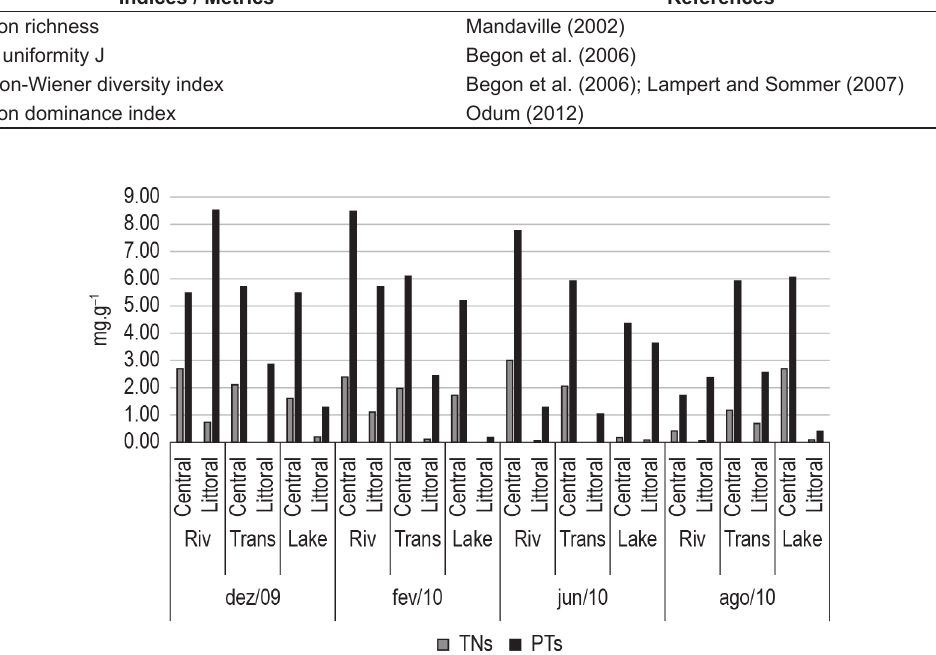
Figure 3. Total nitrogen (TNs) and total phosphorous (TPs) concentrations in the sediment considering central and litoral regins in riverine (Riv), transitional (Trans) and lacustrine (Lake) zones of the Itupararanga reservoir, SP,